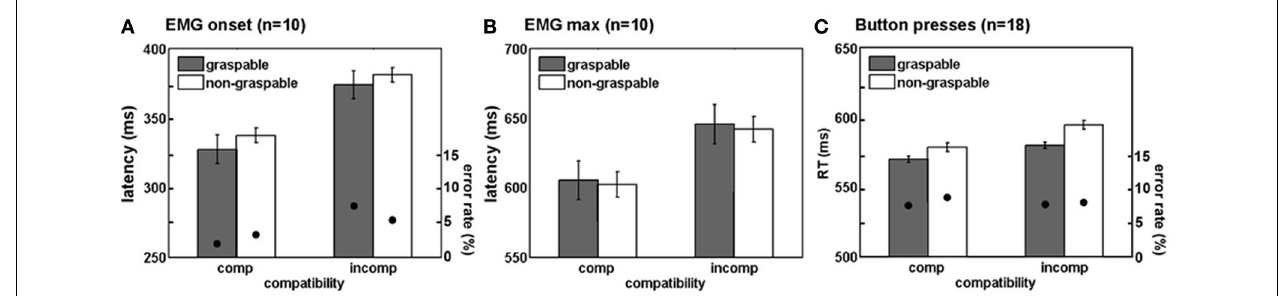
FIGURE 3 | Reaction time and EMG latency results show independent spatial compatibility and affordance effects. Mean reaction times or EMG latencies (bars, left scale) and error rates (black circles, right scale) for intact participants for the four trial types comprising the factorial analysis (see Figure 1B ), during onset of electromyography (EMG)